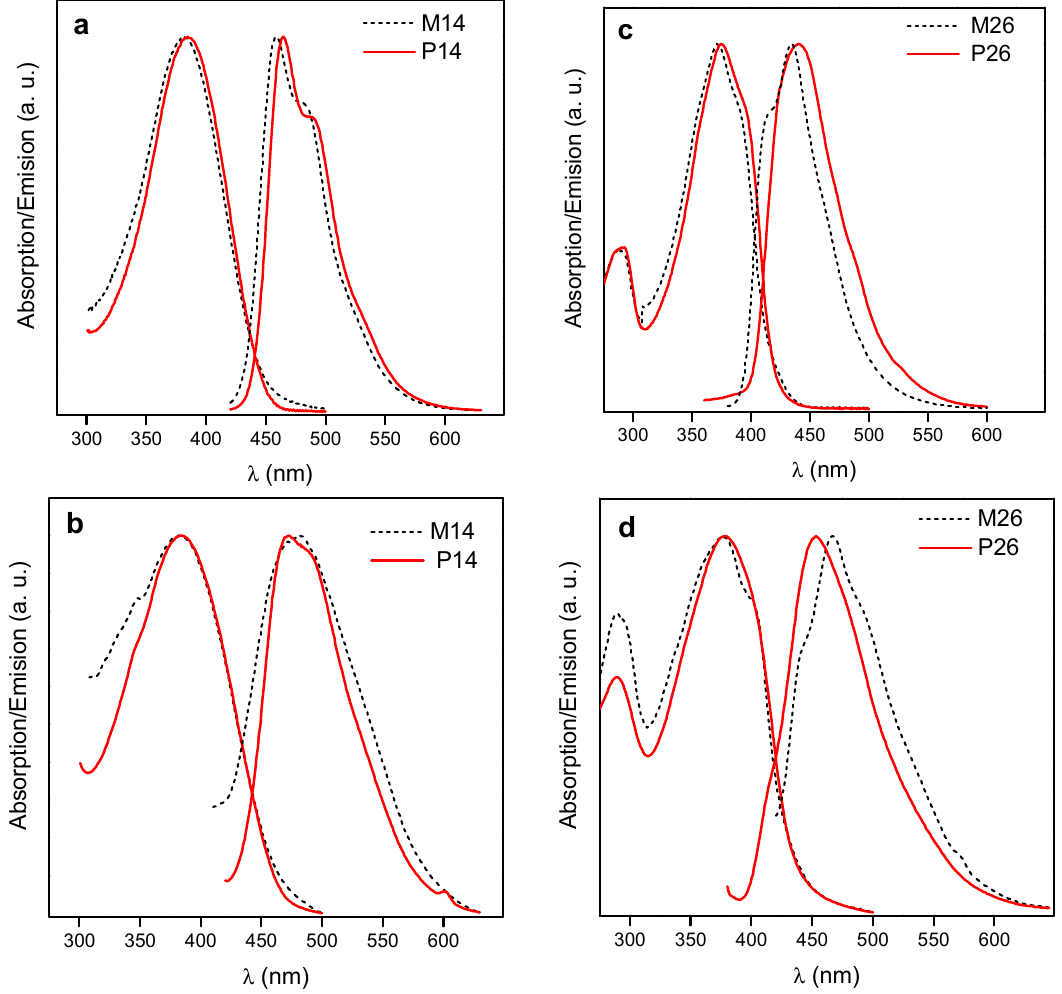
Figure 3. Absorption (left) and emission (right) spectra. ( a , c ) CHCl 3 solutions, ( b , d ) Thin films.